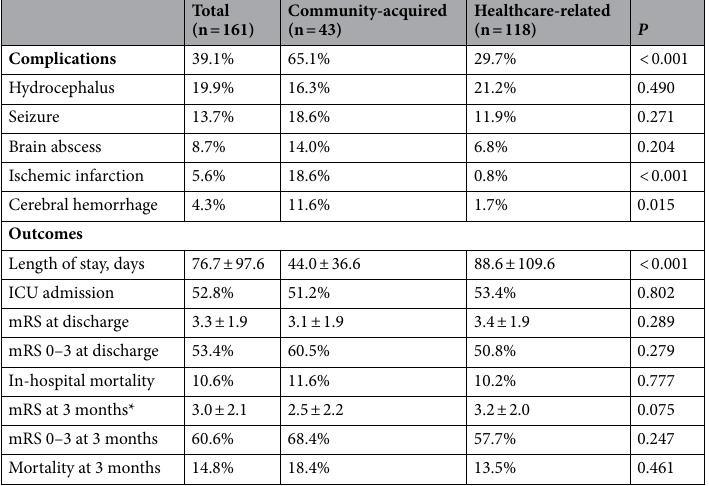
Table 4. Complications and outcome of bacterial meningitis cases. Data are presented as mean ± SD or %. *3-month outcomes were available in 142 cases. Abbreviations: ICU, intensive care unit; mRS, modified Rankin Scale.